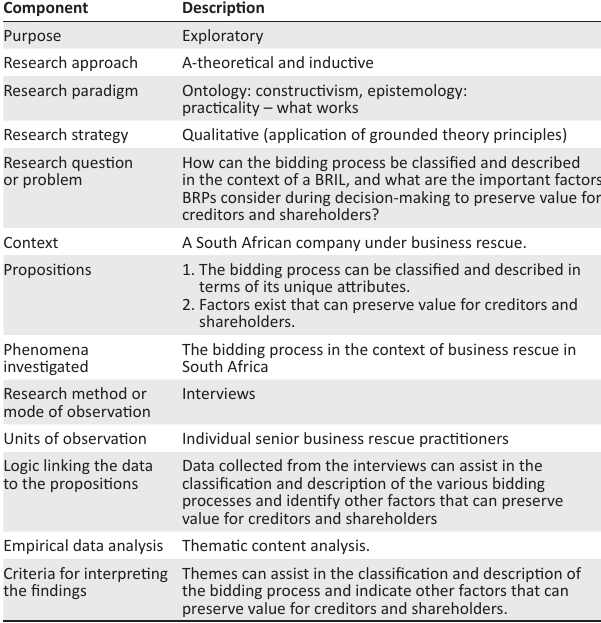
TABLE 2: Research design